Question: Compose a caption that would accompany this figure in a paper.
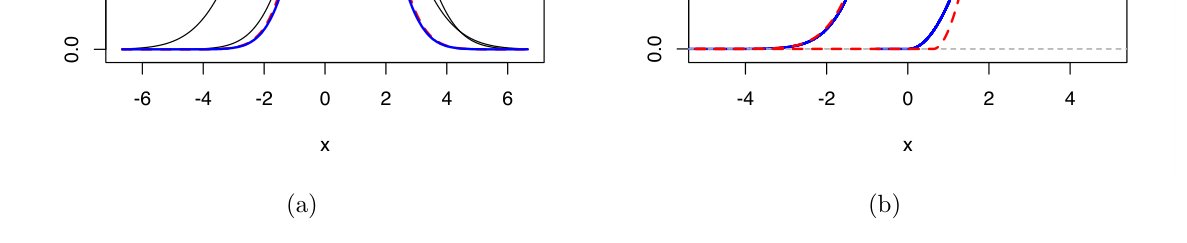
Answer: (a): Two Gaussian possibility distributions (black solid curves) with their normalized product intersection (red broken curve) and the contour function of the combined random set (blue solid curve). (b): Lower and upper cdf’s of the combined possibility distribution (red broken curves) and of the combined random set (blue solid curves).